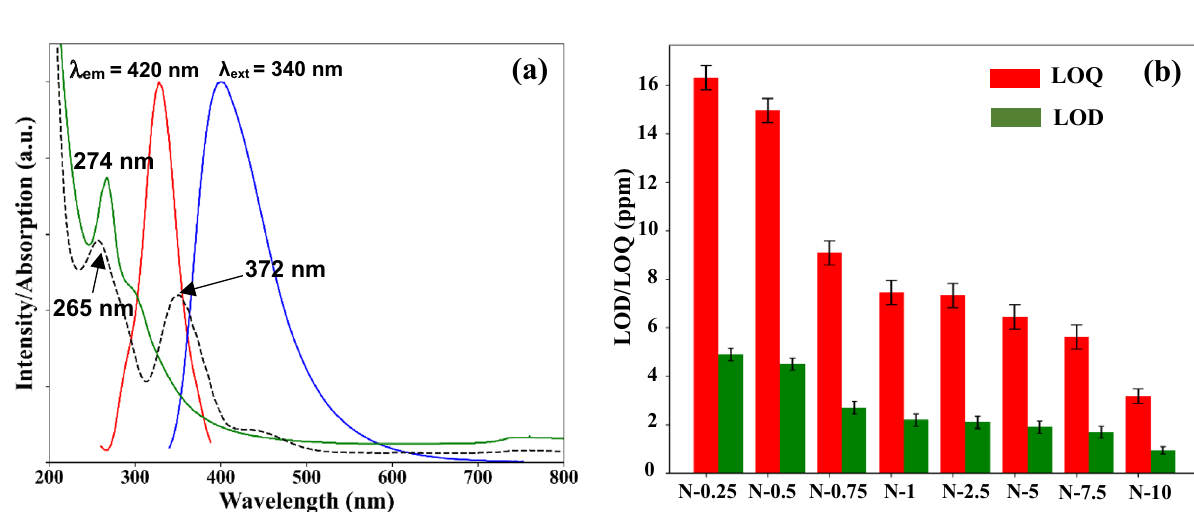
Figure 10. (a) Spectral overlap of the normalized UV–Vis absorption bands for the Cr (VI) ions (dash black) and the synthesised N-CQDs (green line), and the excitation spectrum (λ em = 420 nm) (red line) and emission spectrum (λ ext = 340 nm) (blue line) of the N-CQDs . (b) LOD and LOQ of